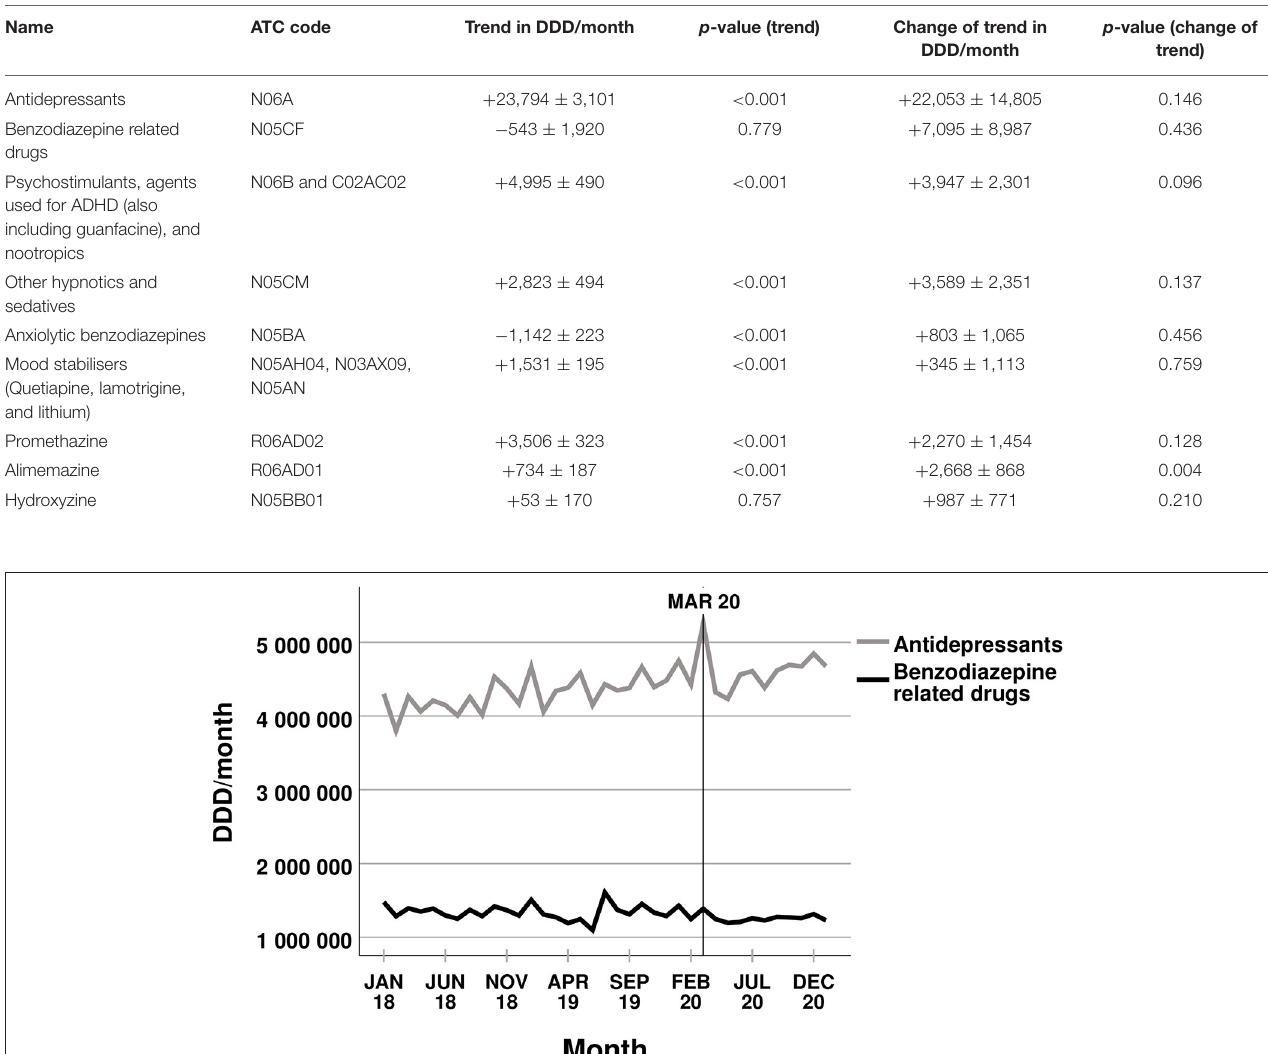
TABLE 1 | Trends, changes of trends, and respective P -values from the ITS analysis of the most common psychotropic medications.